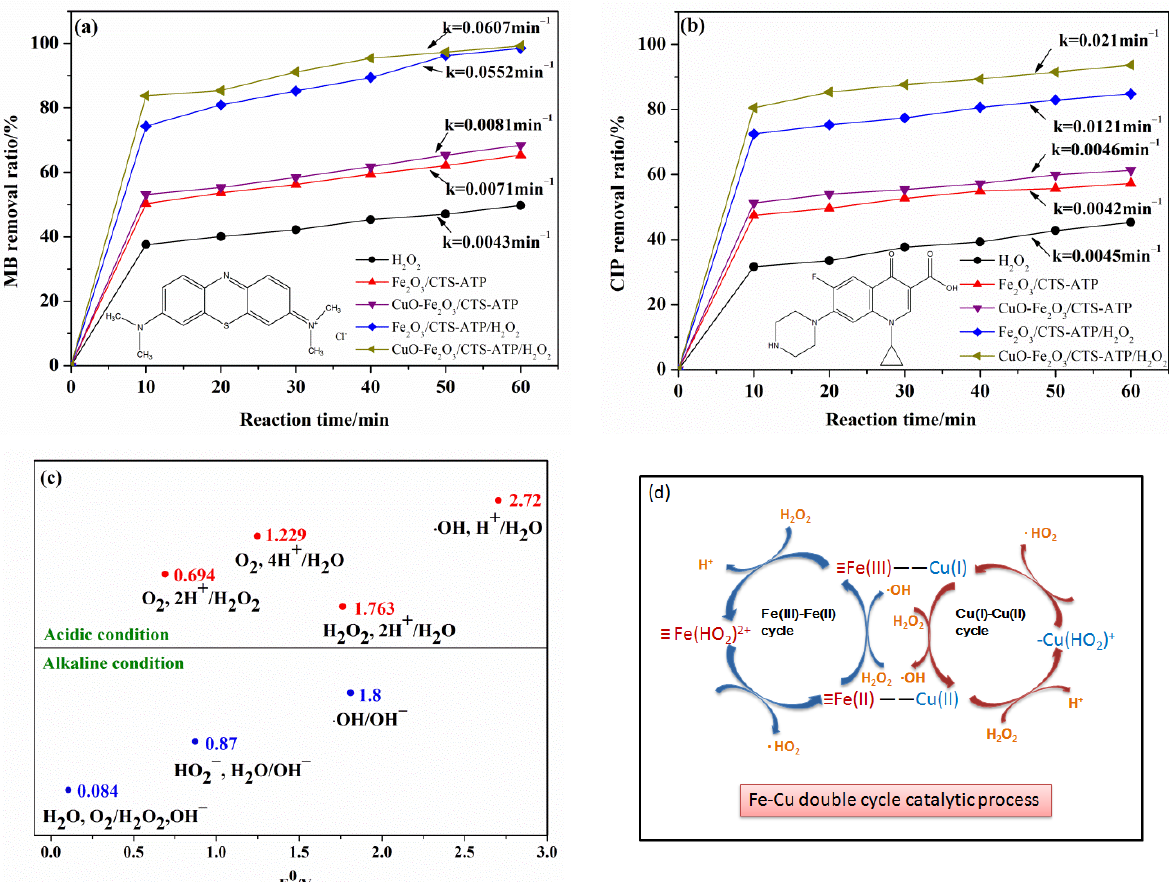
Figure 5. The effects on the MB and CIP removal ratios in different systems ( a , b ) and degradation mechanisms ( c , d ).